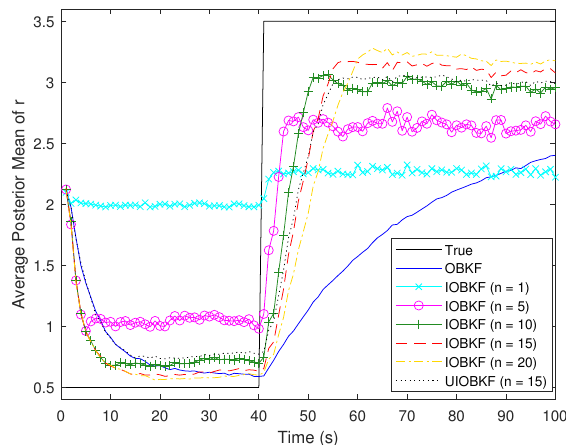
Figure 10. Estimation of noise parameter r